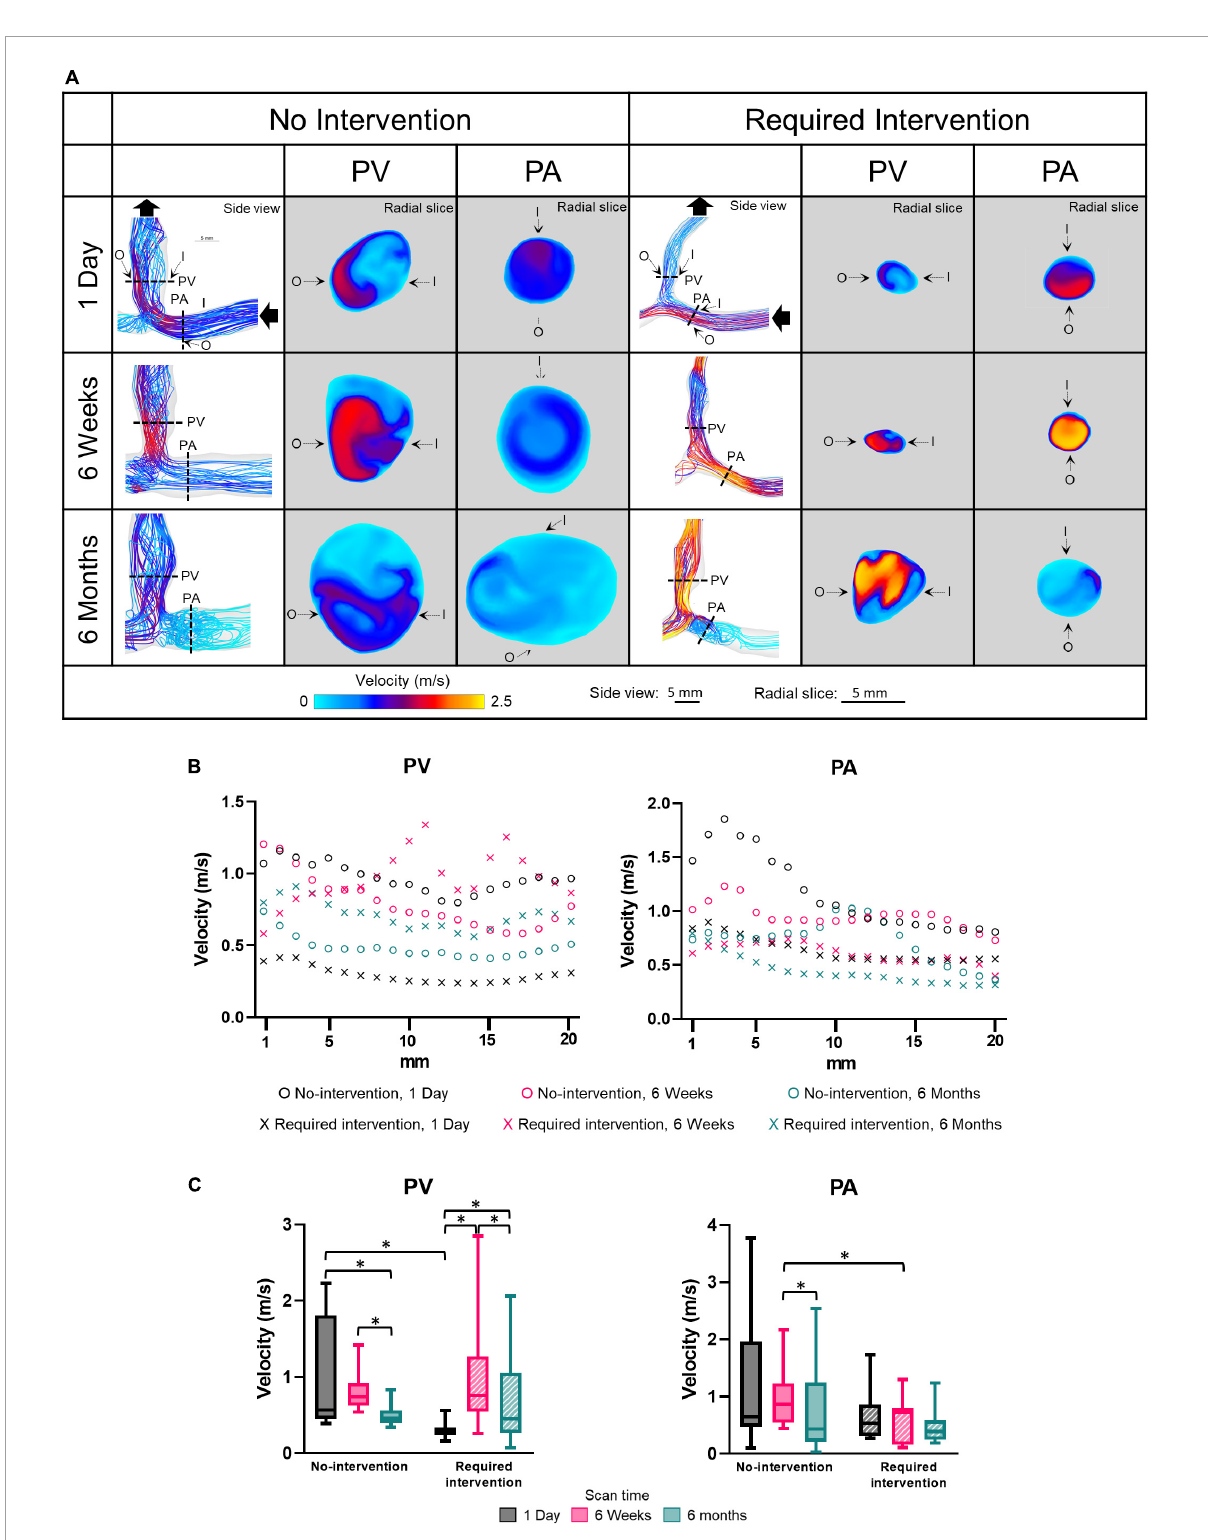
FIGURE3 Velocity of the proximal vein (PV) and proximal artery (PA). (A) Velocity color maps of the side view and radial slices of representative arteriovenous fistulas at systole. Solid black arrows denote the flow direction. Dotted lines in the side view color maps show the location of radial slices, approximately 5 mm from the anastomosis. O and I denote the locations of outer and inner walls, respectively. (B,C) Show velocity for the "no intervention" and "required intervention" groups at 1 day, 6 weeks, and 6 months, as explained in Figure 2 . * P <